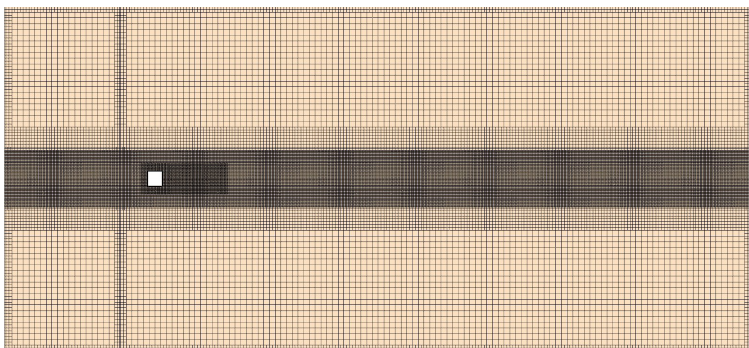
Figure 2. Top View of Meshing Scheme for Surface Mounted